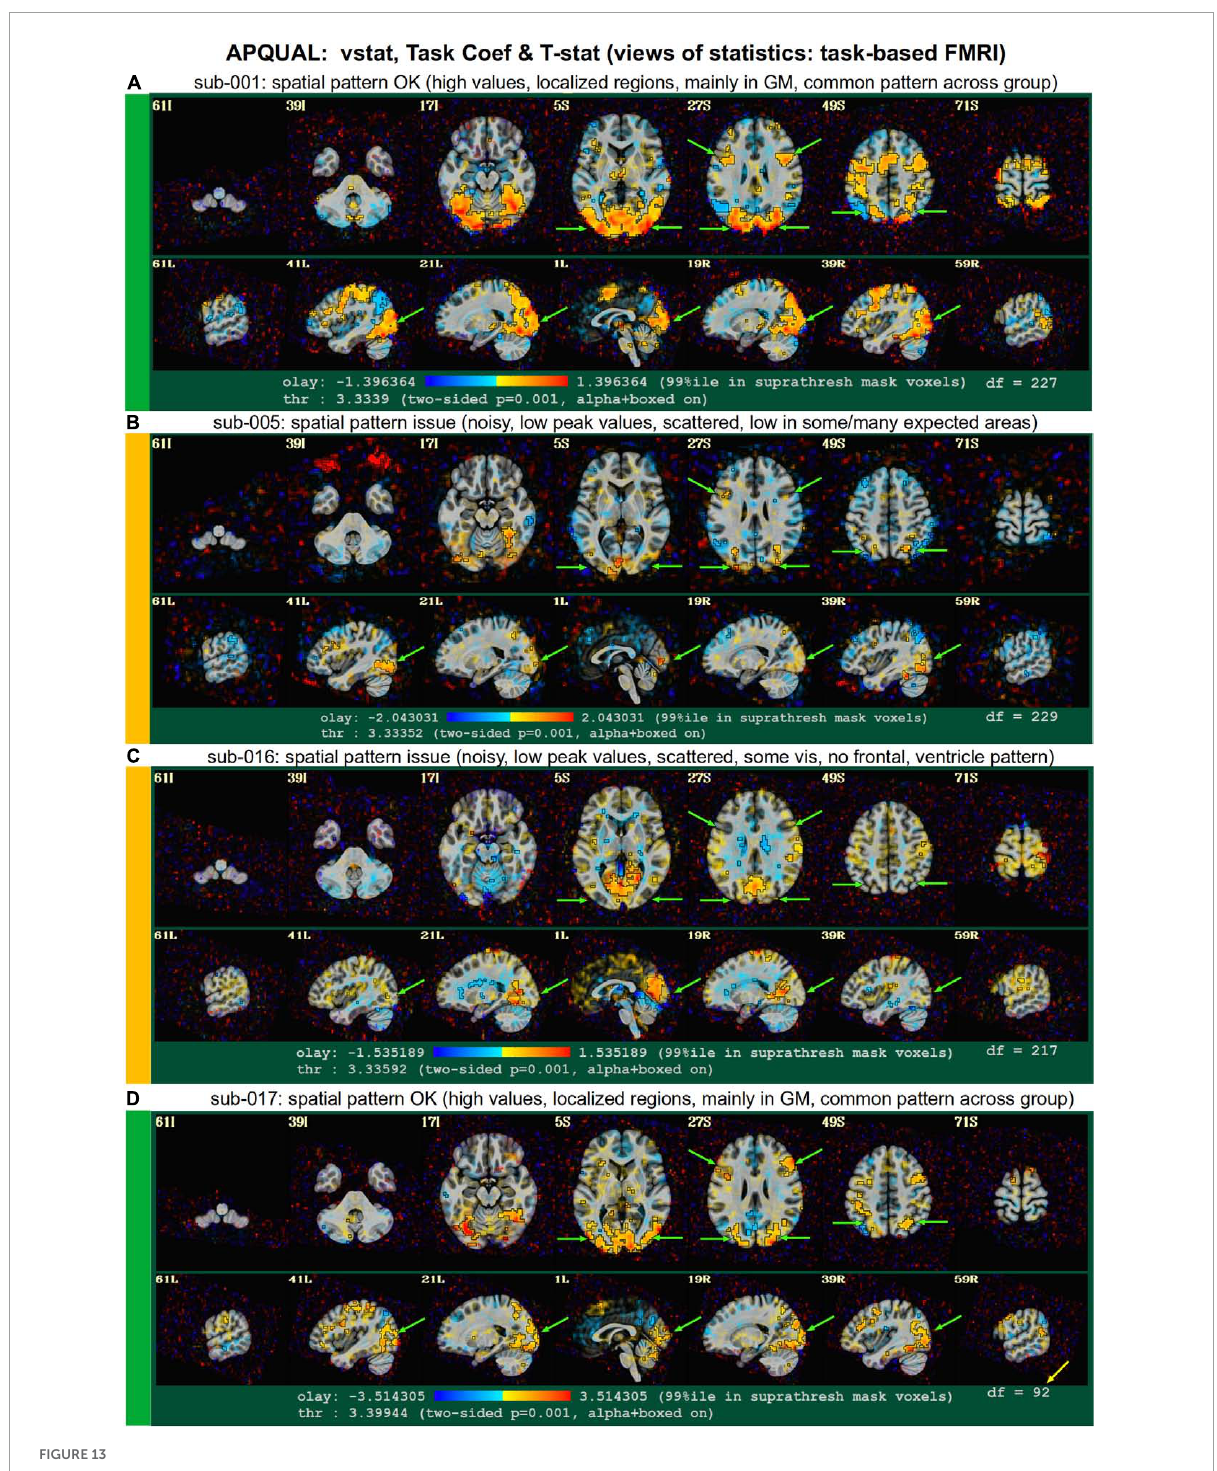
FIGURE13 APQUAL examples for the task-based FMRI group from “vstat” QC block: Visualizations of statistical and modeling information after regression (here, the “TASK” stimulus coefficient is shown as the overlay colors, and its t-statistic values are used for thresholding). Each panel corresponds to that of Figure 12 , though a different aspect of the modeling is shown here: Namely, the task stimulus coefficient that, after scaling, now has physical units of BOLD percent change, as well as the associated statistic (used for thresholding). Similar comments generally apply for each subject to those of Figure 12 , but note that: For sub-005 [panel (B) ], the high F-stat regions in frontal regions in Z = 27S were not strongly associated with this task, unlike in panels (A,D) ; and for sub-016 [panel (C) ], the ventricle pattern noted in the previous figure are negatively associated with the main